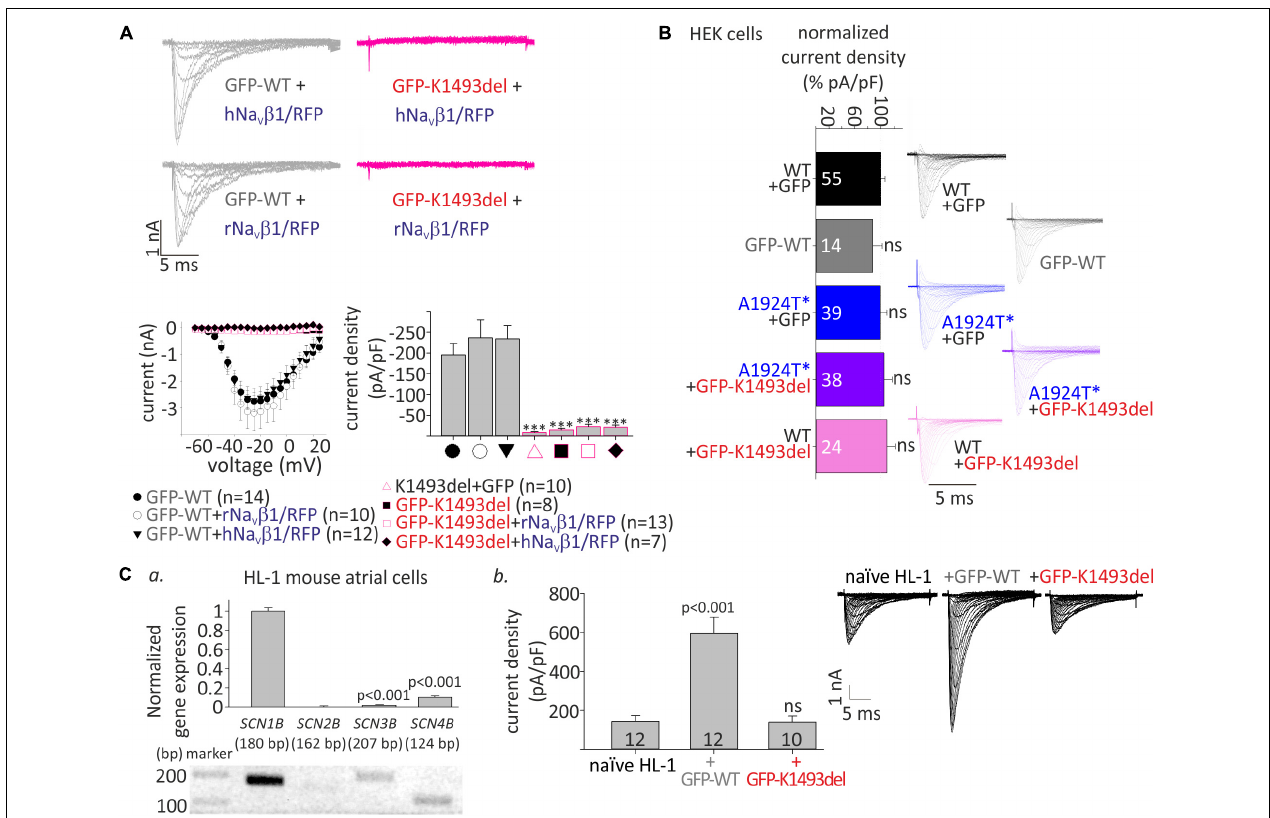
FIGURE 2 | Whole-cell I Na of WT and mutant Na V 1.5 in HEK and HL-1 cells. (A) Top, representative currents elicited from resting potential by depolarizing steps (–70 until –20 mV in 5 mV interval) in HEK cells. Bottom, voltage-dependent amplitudes and maximal current densities, in cells expressing GFP-Na V 1.5 WT , GFP-Na V 1.5 K1493del , and Na V 1.5 K1493del , with and without r/hNa V β 1 co-expressing RFP in the same vector. All groups were compared to GFP-WT for statistical significance. (B) WT and mutant Na V 1.5 expressed in HEK cells (without Na V β subunit). Current densities were normalized to the mean current density of Na V 1.5